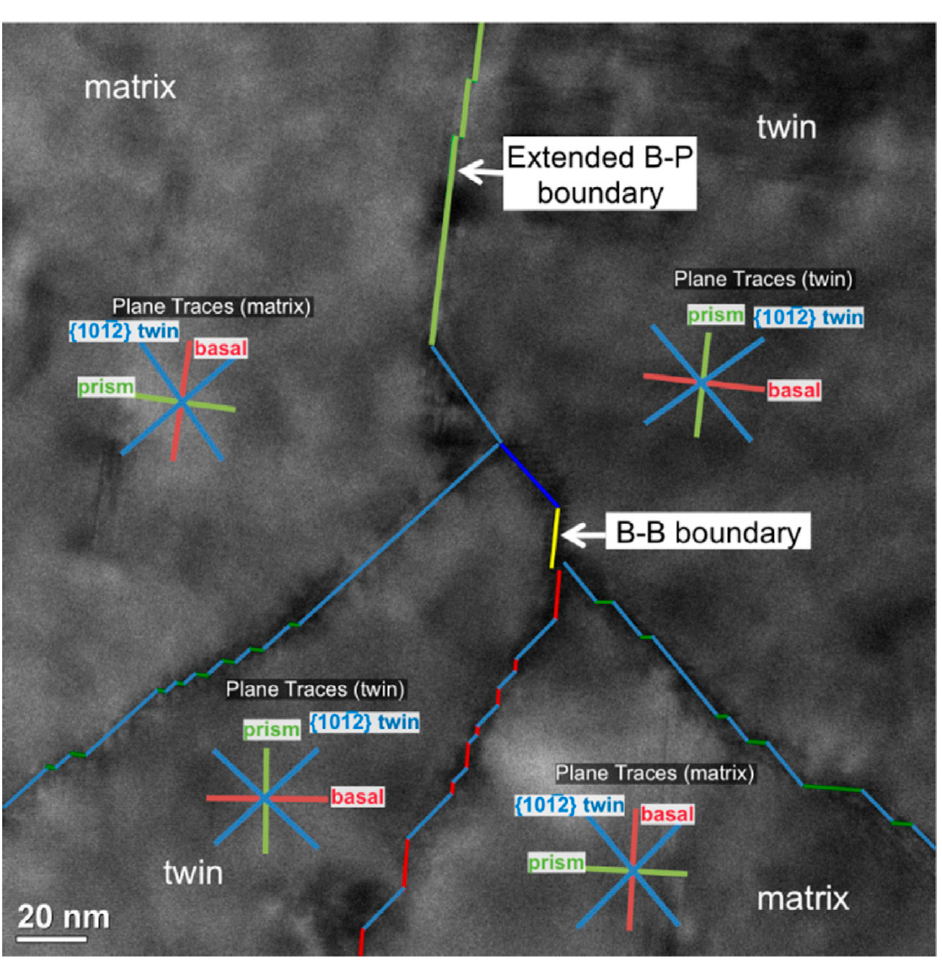
Figure 27. TEM image of a twin–twin intersection with a B-B boundary in Mg. (Reprinted from Reference [13], with permission from Elsevier).